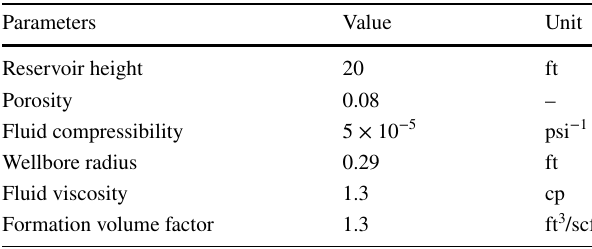
Table 4 Reservoir rock/fluid and well parameters of the pressure tran- sient test (Bourdet et al.